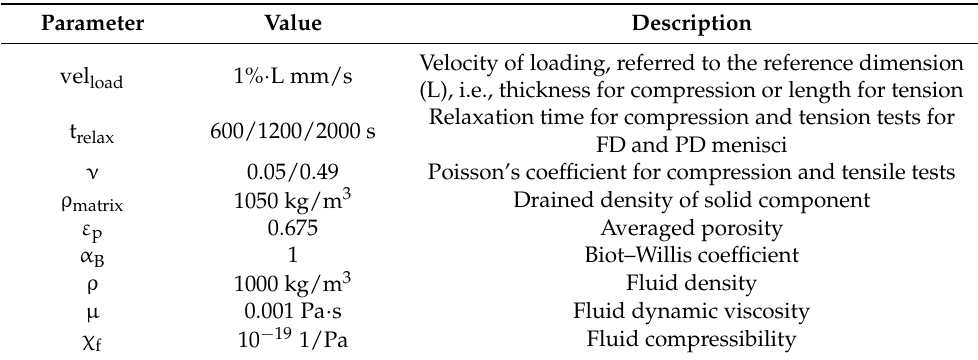
Table 3. Parameters for the numerical